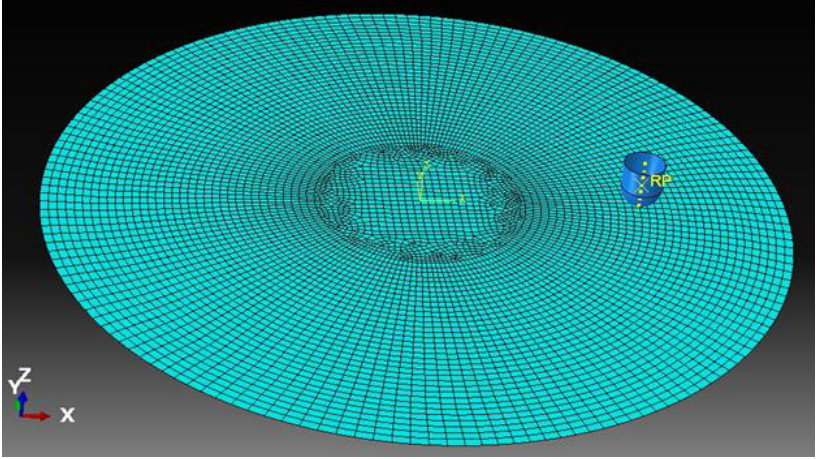
Figure 5. Model assembly and undeformed mesh.